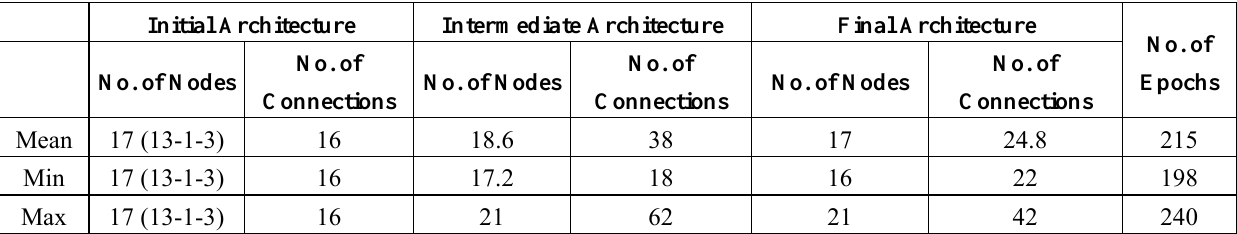
Table 5. ANN architectures and the training epochs for the wine dataset.